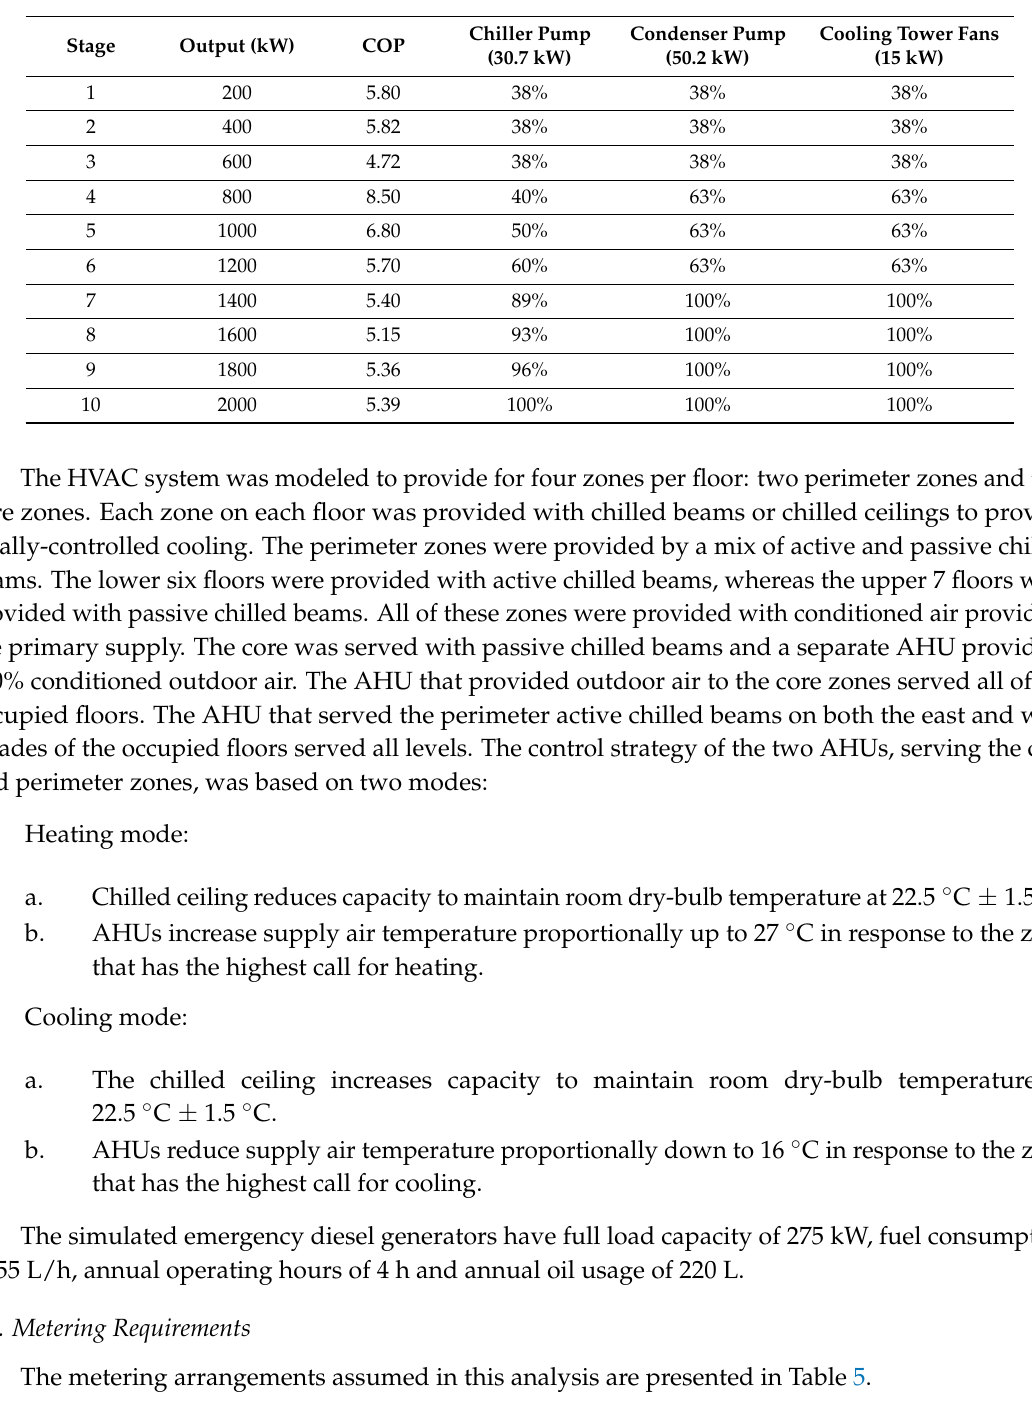
Table 5. Assumed metering